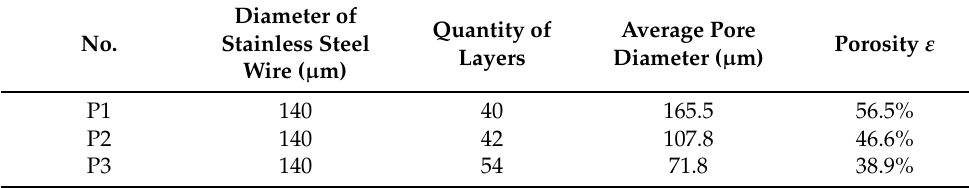
Table 1. Geometric parameters of the tested sintered wire